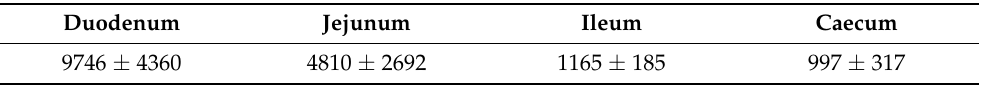
Table 3. Levels of 13-HODE-G (in fmol/mg of tissue ± SEM) in the gastrointestinal tract of mice.